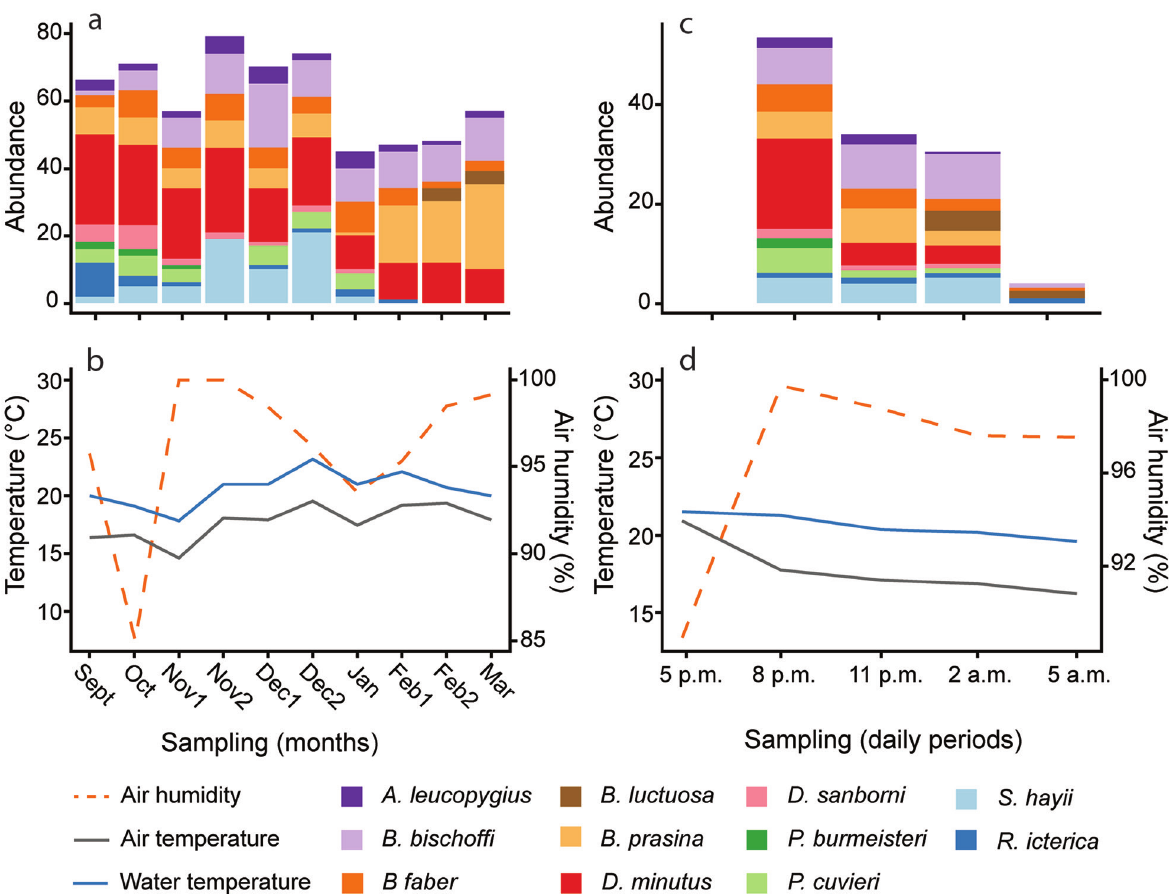
Figure 1. Species richness and abundance variation of 11 amphibian species in a permanent pond in Reserva Biológica Municipal da Serra do Japi ( RBMSJ ), Jundiaí municipality, São Paulo State, Brazil. (a) Total number of individuals in calling activity throughout the reproductive season, with species corresponding to different colors. (b) Variation of mean air humidity and air and water temperatures throughout the reproductive season. (c) Average number of individuals in calling activity in different night periods. (d) Variation of mean air humidity and air and water temperatures throughout the reproductive season different night periods. Orange dashed line = air humidity; grey line = air temperature; blue line = water temperature. Genera corresponds to: Aplastodiscus ( A. leucopygius ), Boana ( B. bischoffi , B. faber , B. prasina ), Bokermannohyla ( B. luctuosa ), Dendropsophus ( D. minutus ,